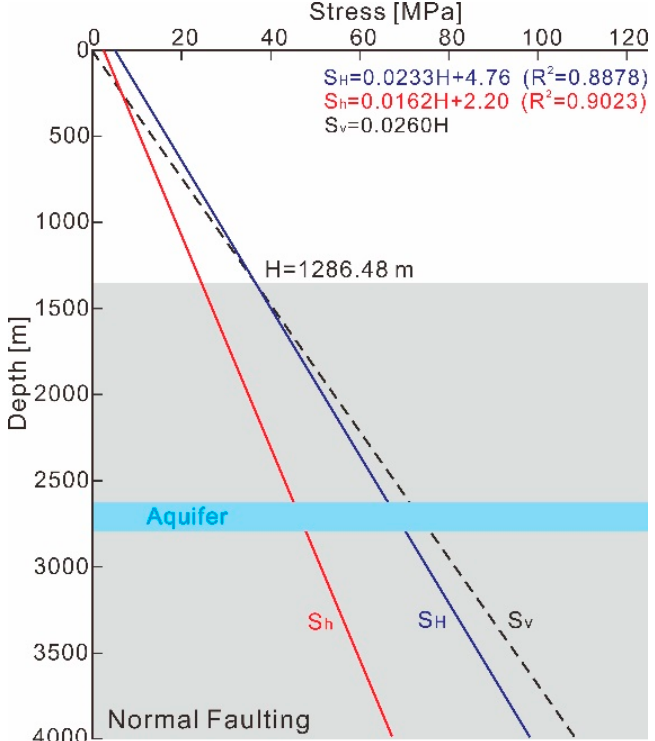
Figure 3. Profiles of the principal stresses with depths in the shallow crust of the Xiong’an New